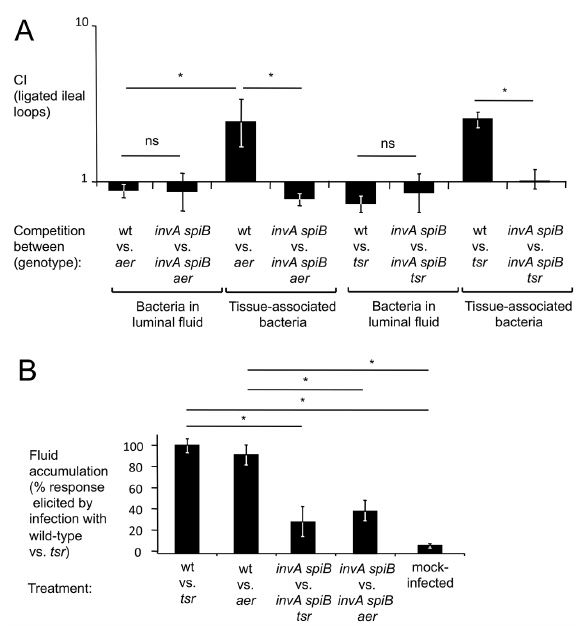
Figure 3. Inactivation of aer or tsr decreases numbers of S. Typhimurium in close proximity to the inflamed mucosal surface. Bovine ligated ileal loops ( N : each inoculum was tested in loops from 4 different animals) were infected with an equal mixture of the indicated S . Typhimurium strains and samples collected 8 hours after infection from the luminal fluid and tissue punches (tissue- associated bacteria). (A) Bars represent geometric means of competitive indices (CI) 6 standard error. (B) Fluid accumulation observed 8 hours after infection expressed as a percent of the response observed in loops infected with an equal mixture of the S . Typhimurium wild-type strain (AJB715) and a tsr mutant. Bars represent geometric means 6 standard error. *, P , 0.05; ns, not significantly different.